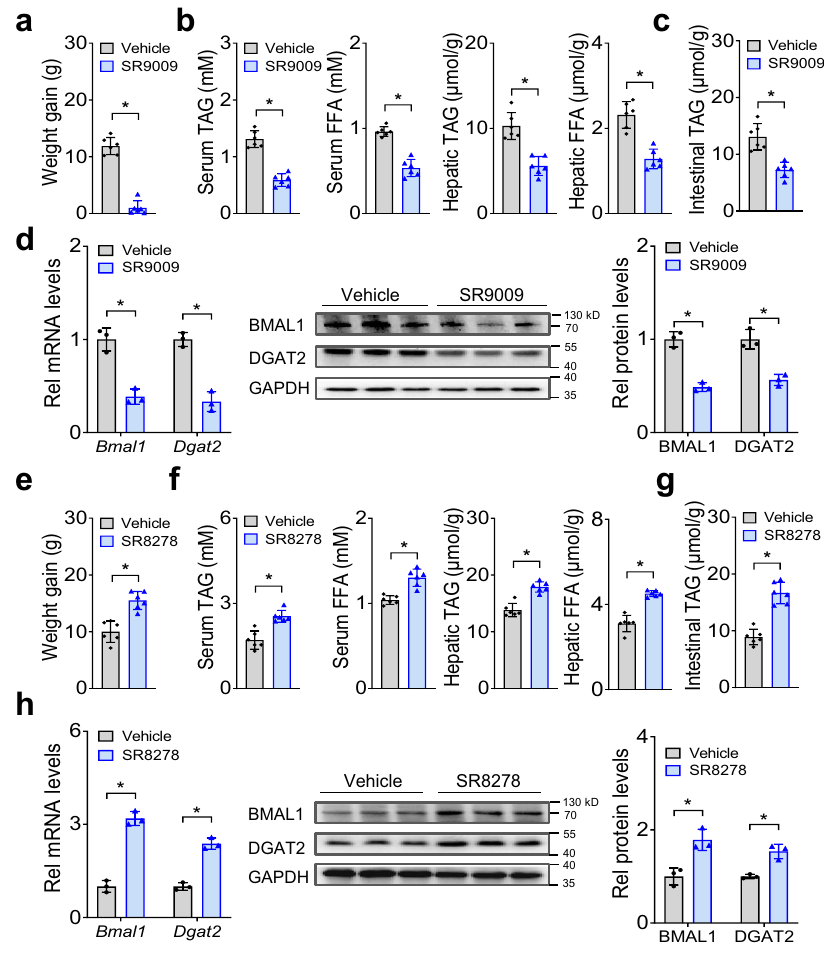
Fig. 8 Small-molecule targeting of REV-ERB α /BMAL1 ameliorates HFD-induced obesity. a Effects of oral SR9009 on body weight gain in HFD-fed mice (wild-type). 6-week-old mice were fed HFD for 4 weeks. The mice continued on HFD and were gavaged with SR9009 (100 mg/kg) or vehicle once daily for 4 weeks. Body weights were measured after 4-weeks drug treatment. Two-sided t test p value: < 0.0001. b Effects of oral SR9009 on serum and hepatic TAG and FFA levels. Two-sided t test p values (from left to right): <0.0001, <0.0001, <0.0001 and <0.0001. c Effects of oral SR9009 on intestinal TAG level. Two-sided t test p value: 0.0003. d Effects of oral SR9009 on BMAL1 and DGAT2 expression in small intestine of mice. Western blot strips (two target proteins and a loading control) were cut from one gel. Two-sided t test p values (from left to right): 0.0020, 0.0009, 0.0007 and 0.0033. e were gavaged with SR8278 (100 mg/kg) once daily for 4 weeks. Body weights were measured after 4-weeks drug treatment. Two-sided t test p